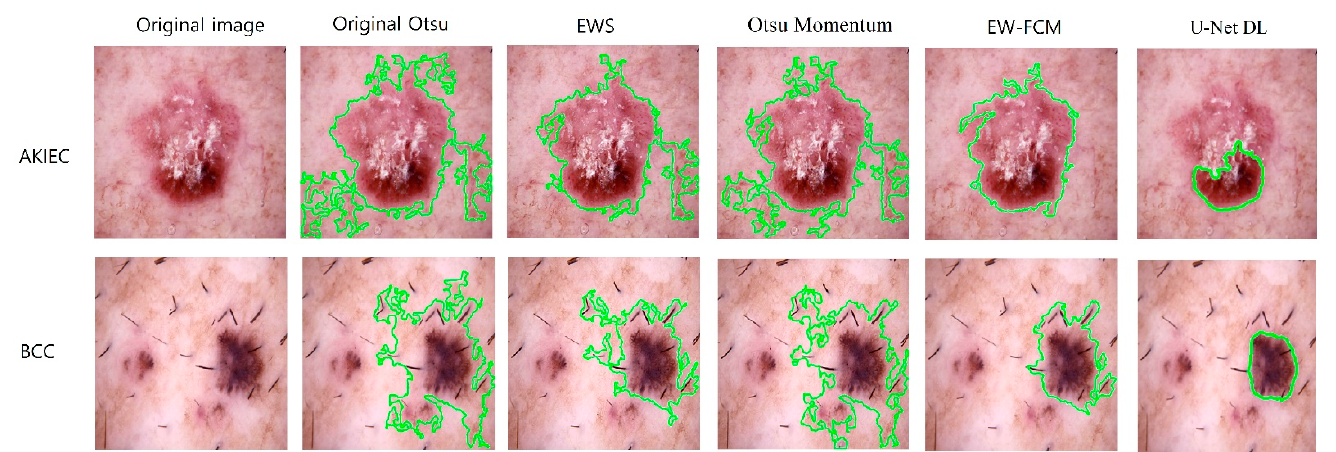
Figure 8. Segmentation results of various segmentation methods. Table 7. Comparison with segmentation methods on the HAM10000 and ISIC2019 datasets (micro- average).